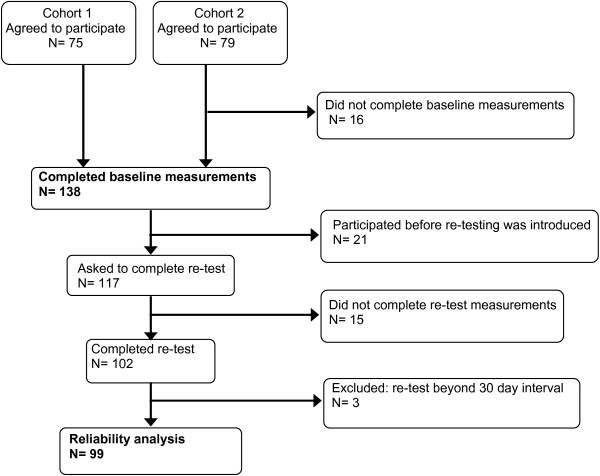
Flowchart showing selection of patients who participated in the study.